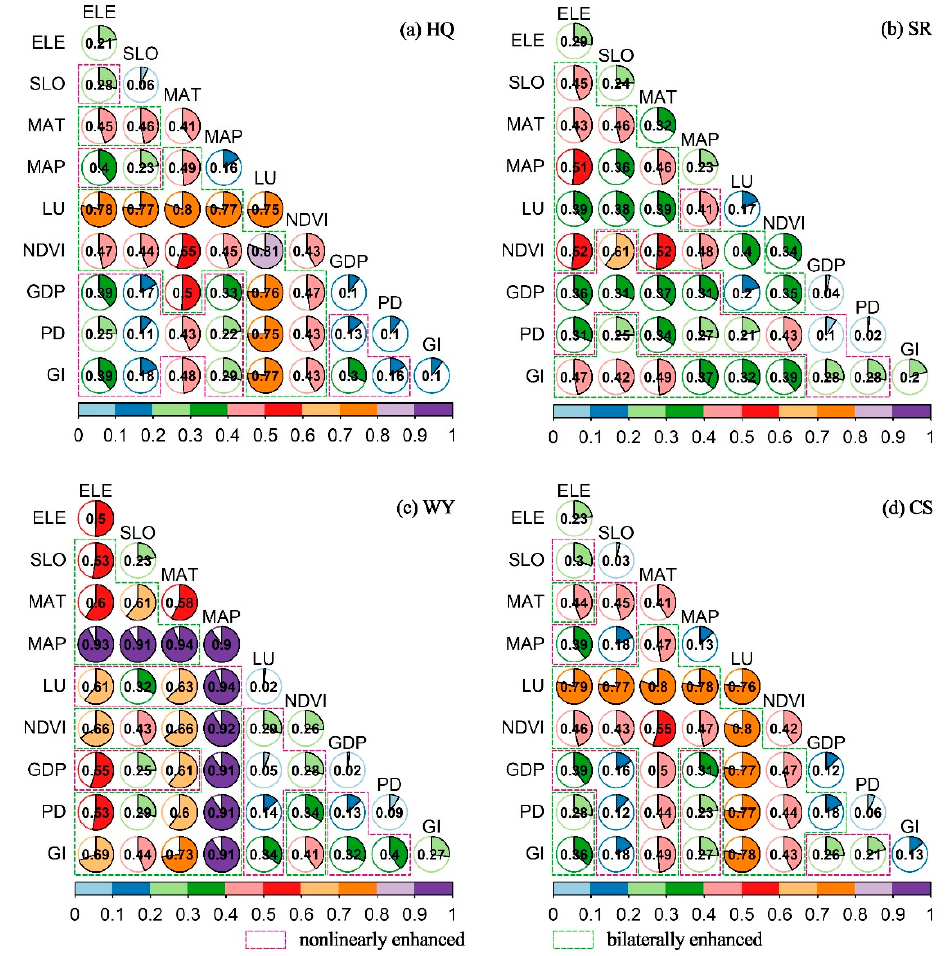
Figure 9. Interactive effects of each set of paired factors on ESs in the Tianshan Mountains.